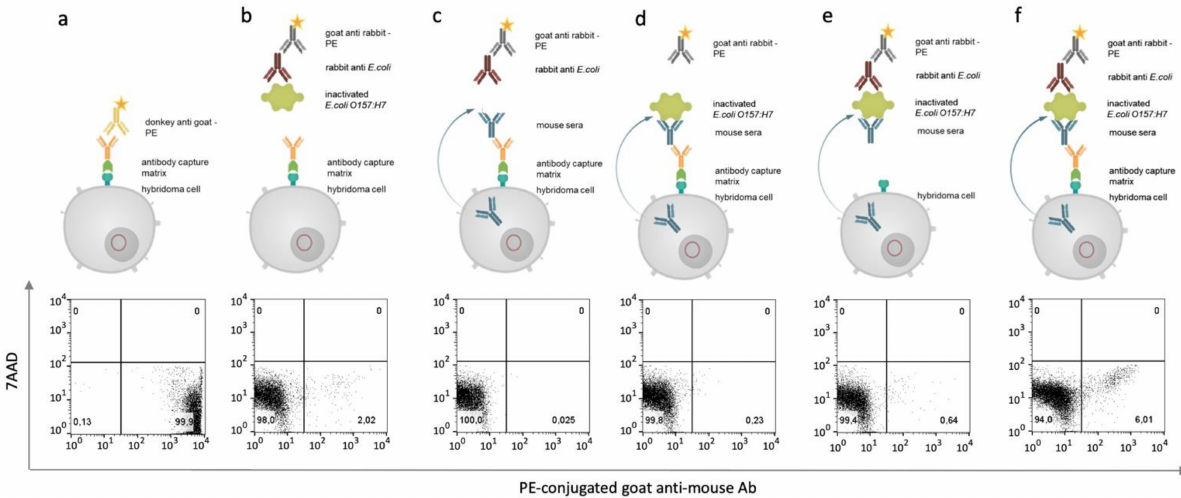
Figure 4. Establishment of a staining protocol for the sorting of specific antibody-producing hybridomas for the antigen E. coli O157:H7. Illustrated are the schematic sorting assembly and their flow cytometric measurements. The dot plot shows the live–dead marker 7AAD against the PE signal. ( a ) Detection of the antibody capture matrix on transgenic myeloma cells. ( b ) The sorting approach without the secreted antibody (imitated by the mouse serum). ( c – e ) Sorting approach without the antigen E. coli O157:H7, rabbit anti- E. coli Ab, or the antibody capture matrix. ( f ) Overall structure of the final sorting approach. The cells have an antibody capture matrix. The secreted antibody of the hybridoma cell is imitated by the VP-EC3 mouse serum. Inactivated E. coli O157:H7 cells represent the antigen. The antigen is bound by the polyclonal rabbit anti- E. coli antibody, which in turn is detected by the polyclonal goat anti-rabbit antibody coupled to